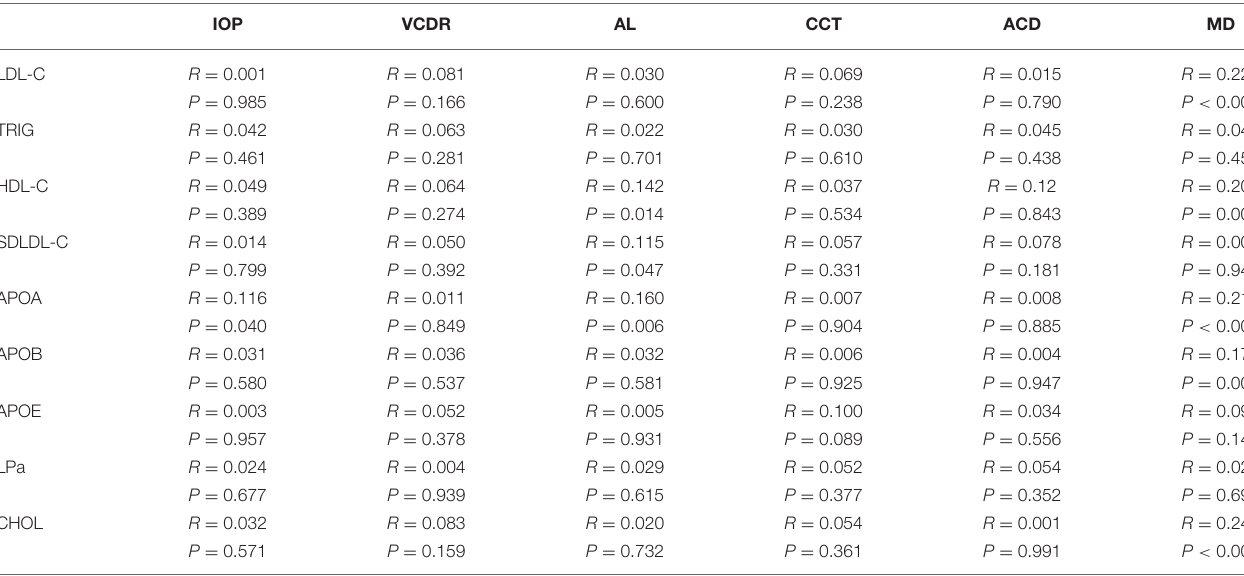
TABLE 2 | Association between serum lipids and ocular